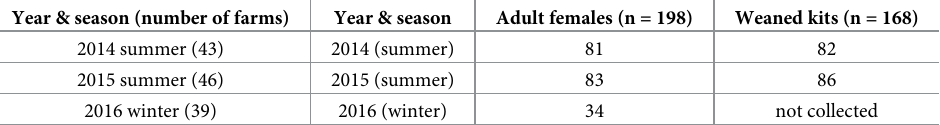
Table 2. Number of samples used in the final analysis of the fecal microbiota of commercial